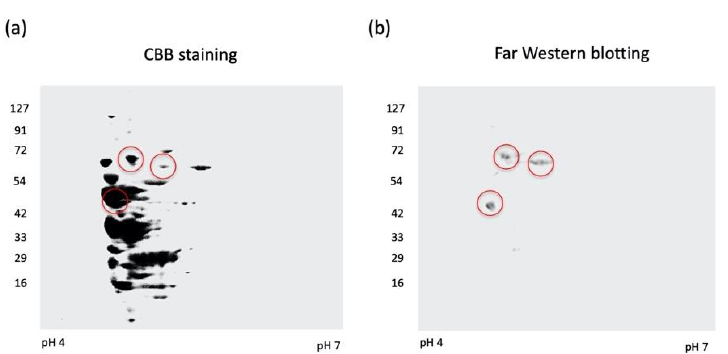
Figure 1. Two-dimensional electrophoresis and Far-Western blotting. Bacterial cells of A. defectiva ATCC (7.5 × 10 6 CFU) were lysed and isoelectric focusing, followed by SDS-PAGE, was applied. Gel stained with Coomassie Brilliant Blue (CBB) ( a ) and the membrane blotted protein was incubated at 4 ◦ C overnight with 50 µ g/mL of fibronectin and then probed with rabbit anti-fibronectin antibodies diluted at 1:500 in PBS (pH 7.0). The membrane was then washed with PBST and incubated with a 1:2500 dilution of goat anti-rabbit IgG conjugated with HRP ( b